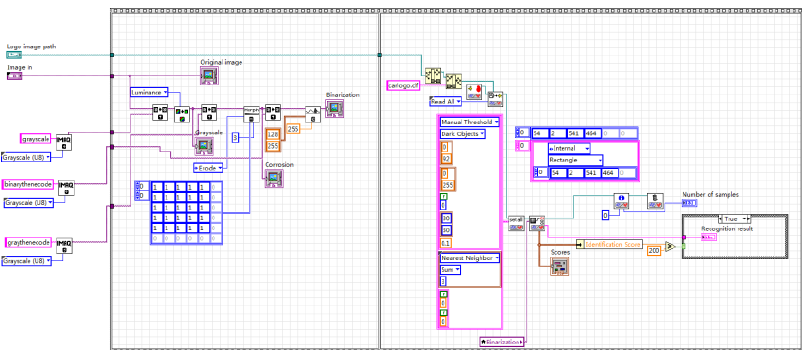
Figure 12. Overall program block diagram of the vehicle logo recognition.